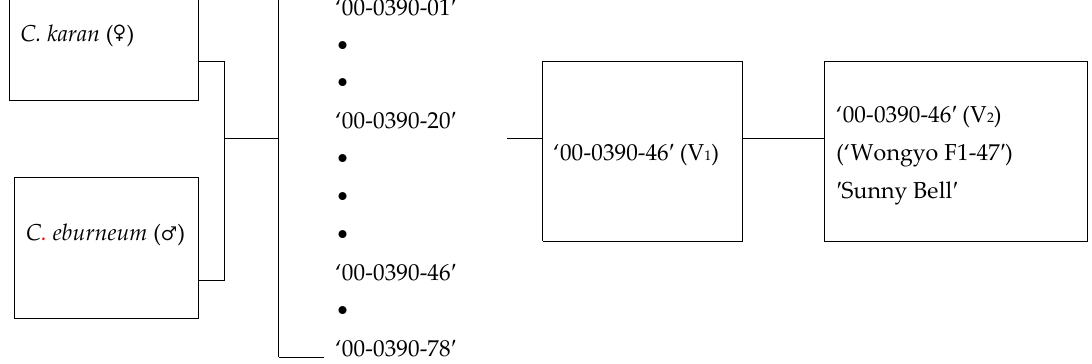
Figure 1. New hybrid Cymbidium “Sunny Bell” plant ( A ), flower ( B ), and floral organs ( C ). Artificial cross Selection